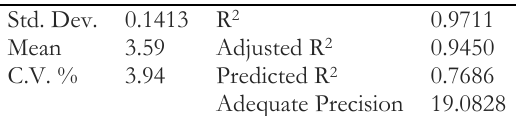
Table 5. Model summary statistics for tensile